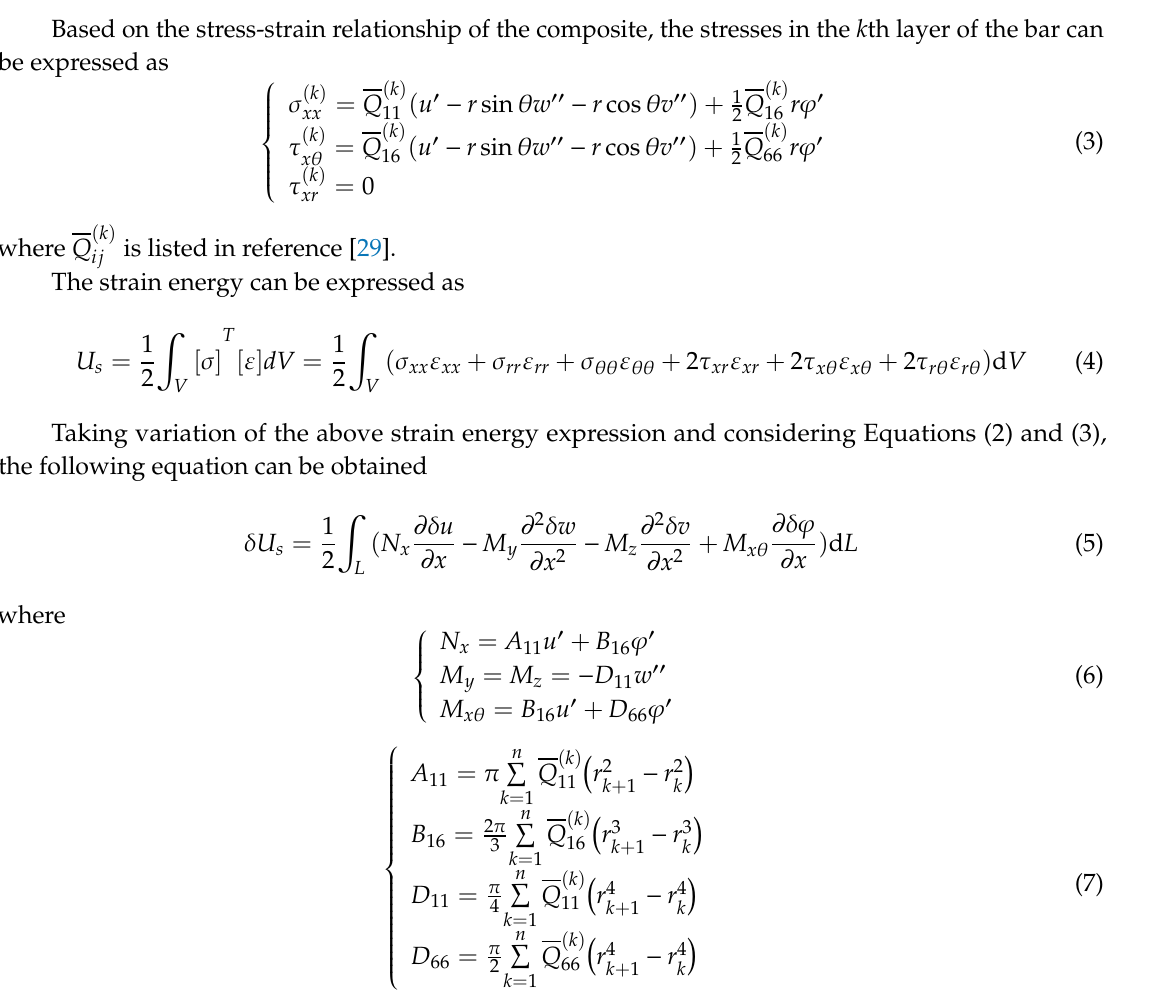
Figure 2. The elastic displacements of a typical cross-section of the